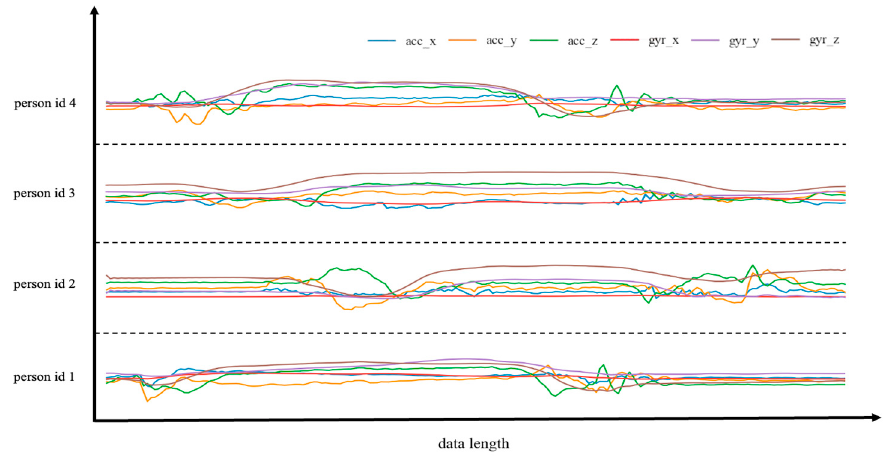
Figure 4. In the same action mode, the data of four volunteers (id1, id2, id3, id4) are randomly selected for display. We uniformly downsampled the data length to 200 for display clarity. It was challenging to classify classroom behavior since each participant carried out the same action in different ways and had unique sensor data patterns.